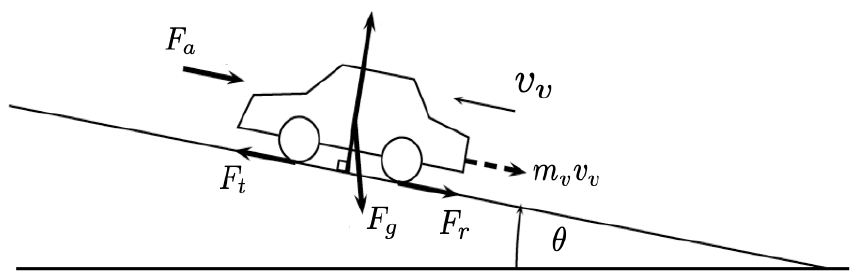
Figure 1. Diagram of forces acting upon the